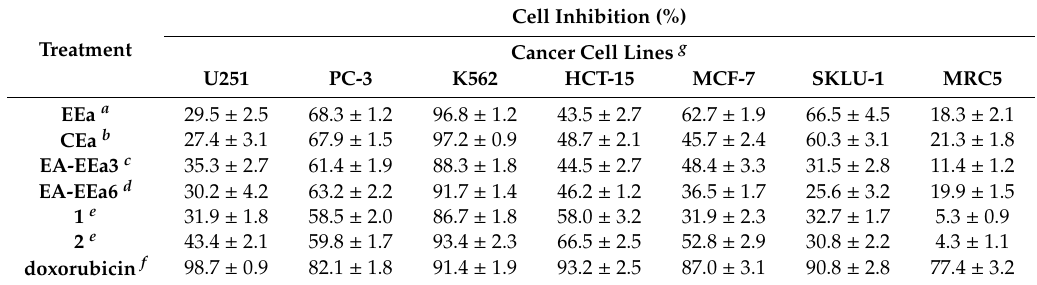
Cell Inhibition (%) Cancer Cell Lines